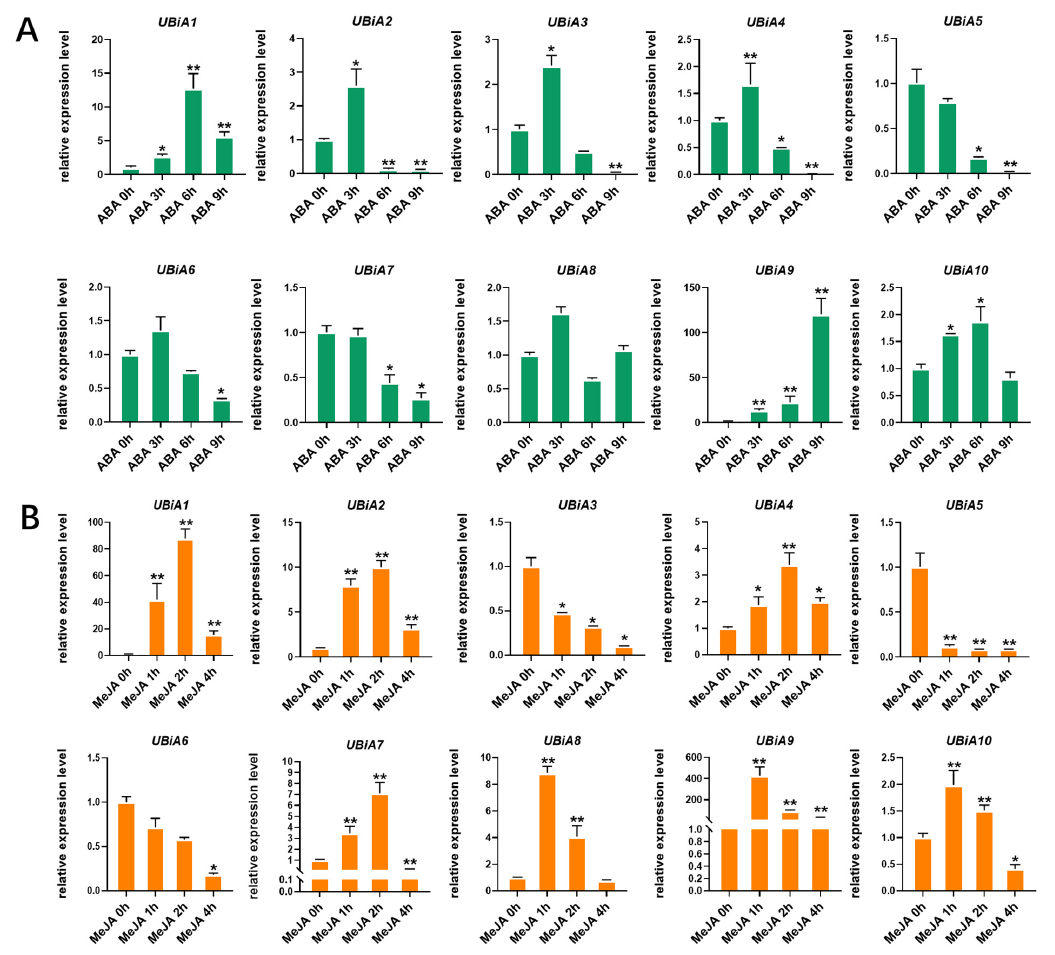
Figure 6. Expression analysis of 10 UBiA genes in leaves under ABA and MeJA hormone treatment in H. annuus . ( A ) 50 μ mol/L ABA treatment. ( B ) 200 μ mol/L MeJA treatment. Fourteen-day-old